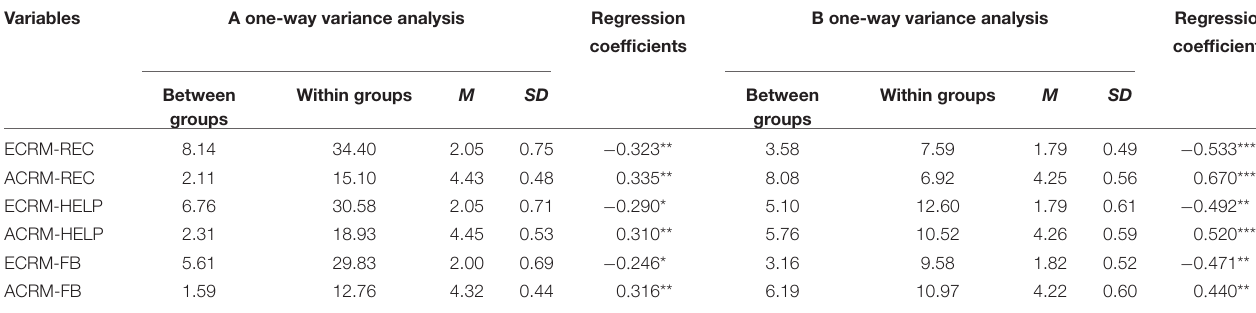
TABLE 2 | Results of one-way variance analysis.